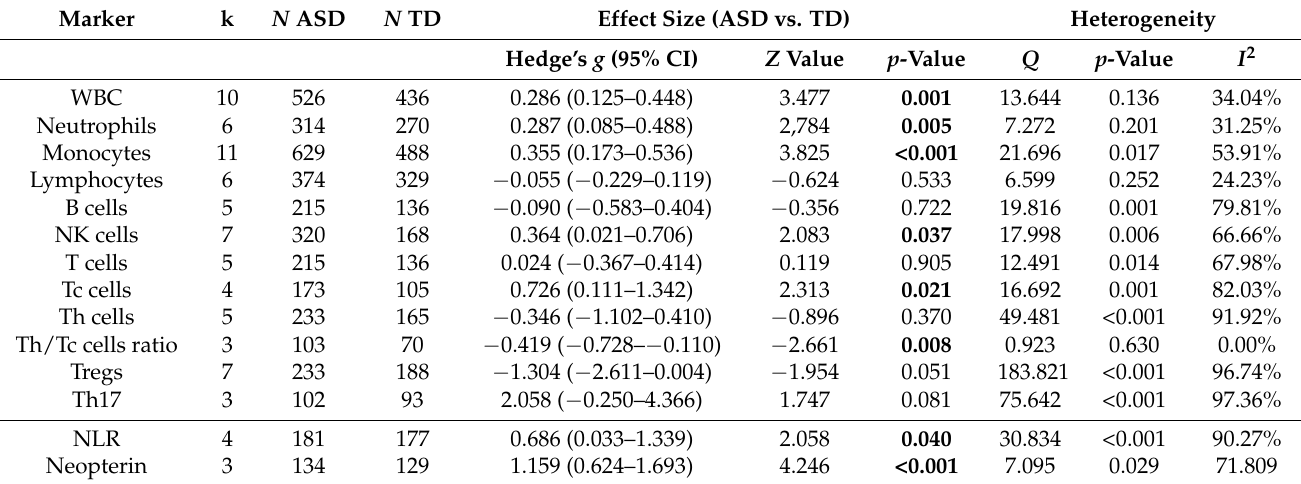
Table 2. Meta-analyses of cross-sectional comparisons of immune/inflammatory markers between individuals with ASD and TD